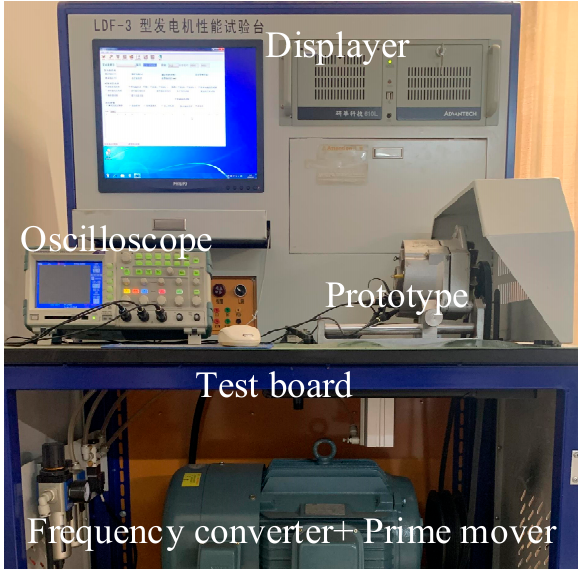
Figure 24. Compound excitation generator prototype experimental platform.